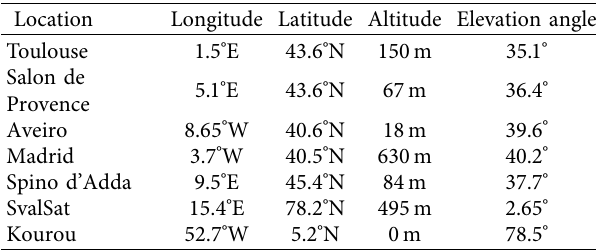
Table 3 gathers the mean climatological normals for each experimental site considered in this study.